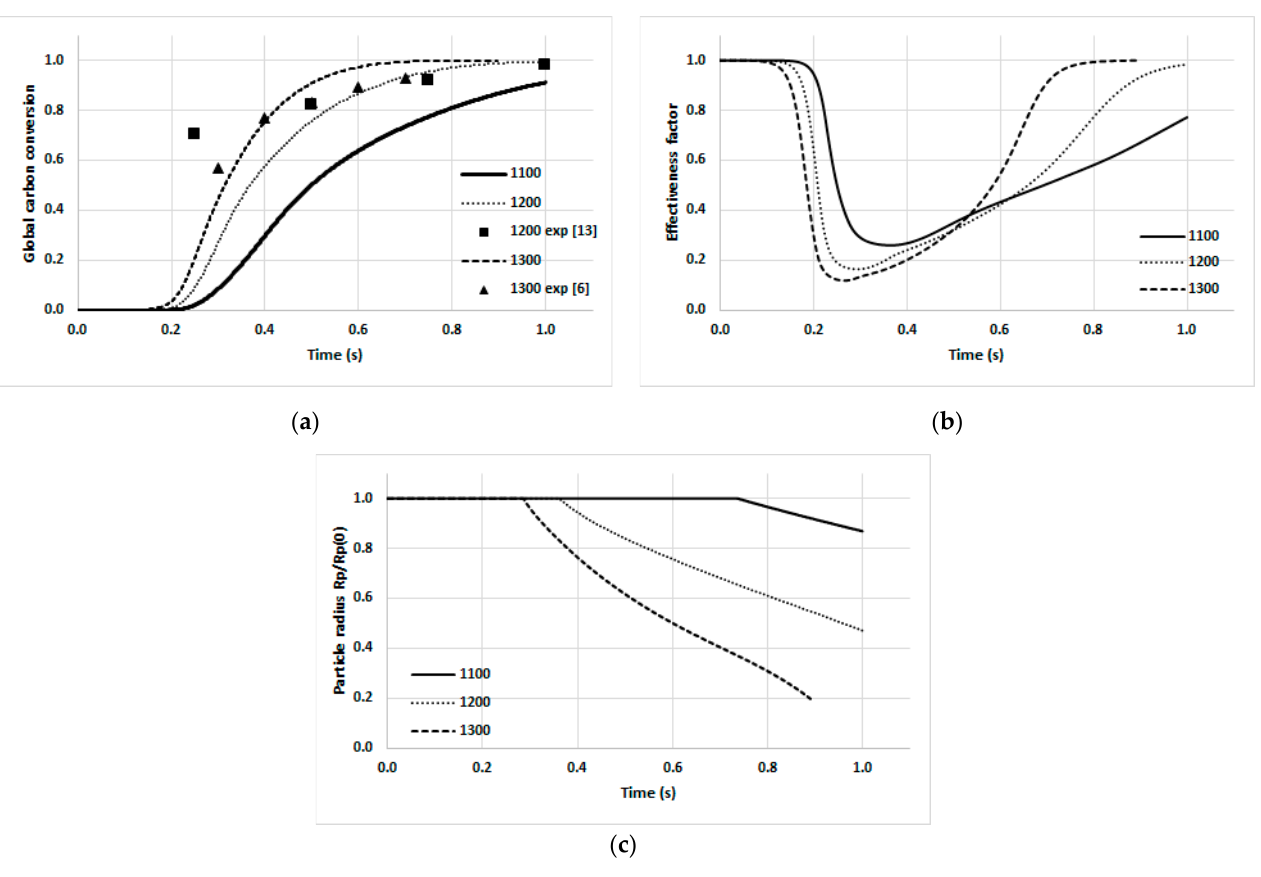
Figure 3. Global carbon conversion ( a ), effectiveness factor ( b ) and normalized radius of the coal char particle ( c ), during its combustion in the drop tube furnace, for the regulation temperature of 1100 (solid line), 1200 (dotted line) and 1300 ◦ C (hyphened line). The black squares and triangles in Figure 3a correspond to experimental data found in the literature, see the comments below.